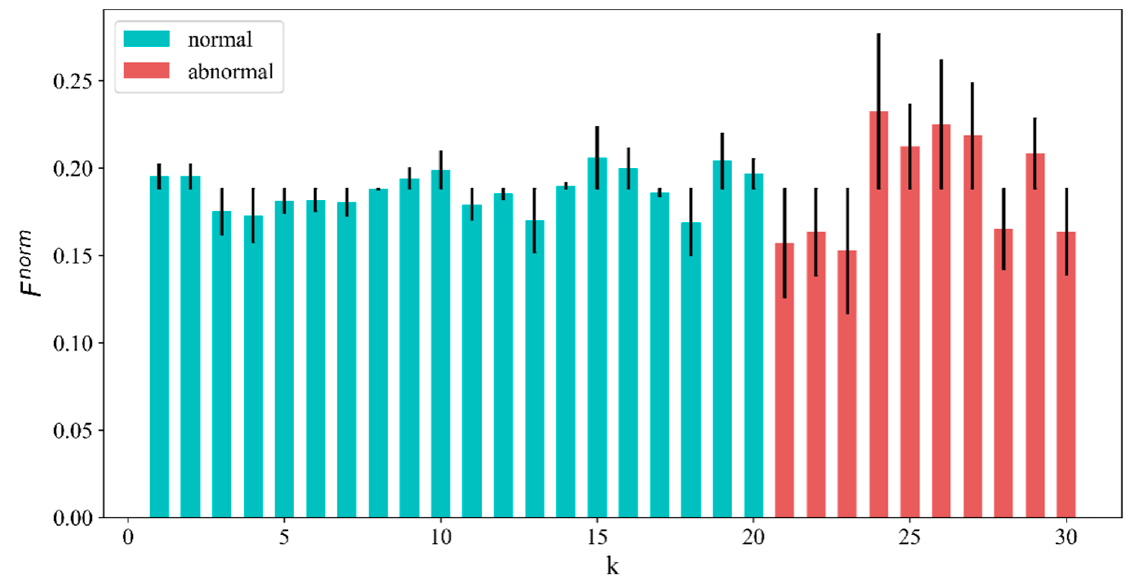
Figure 6. Statistical Frobenius norm to rank abnormal samples.